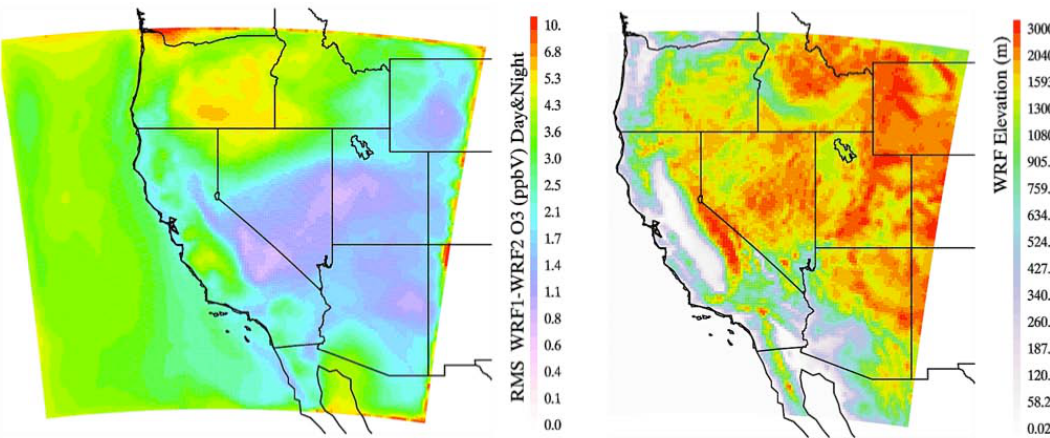
Fig. 11. Left hand side: RMS difference in surface O 3 between the WRF-Chem simulations with temporally varying and with temporally averaged chemical boundary conditions. Right hand side: Elevation (m) over the regional